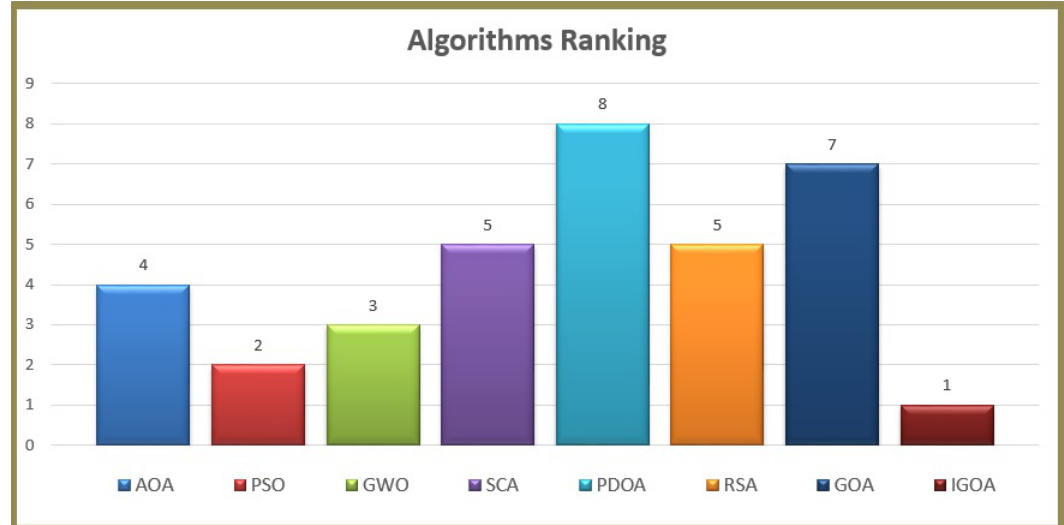
Figure 10. The ranking of the tested methods for the data clustering